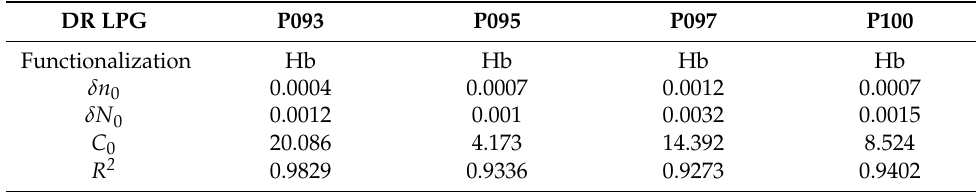
Table 2. Parameters for the logarithmic fit for the response to protein